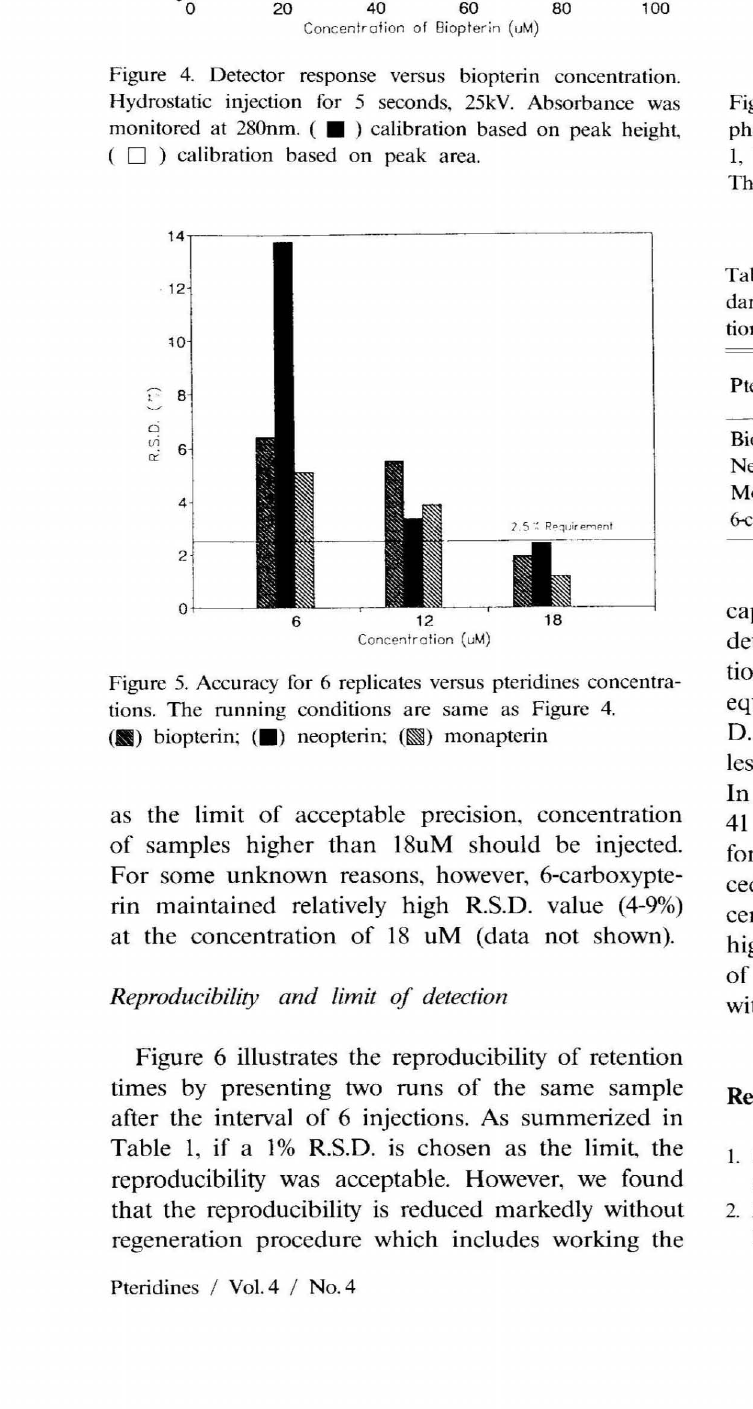
Figure 4. Detector response versus biopterin concentration. Hydrostatic injection for 5 seconds, 25kY. Absorbance was monitored at 280nm. ( • ) calibration based on peak height, ( 0 ) calibration based on peak area.